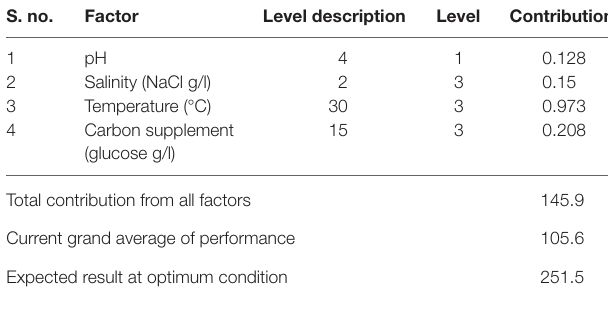
TaBle 12 | Optimum conditions and their contribution on carbohydrates.